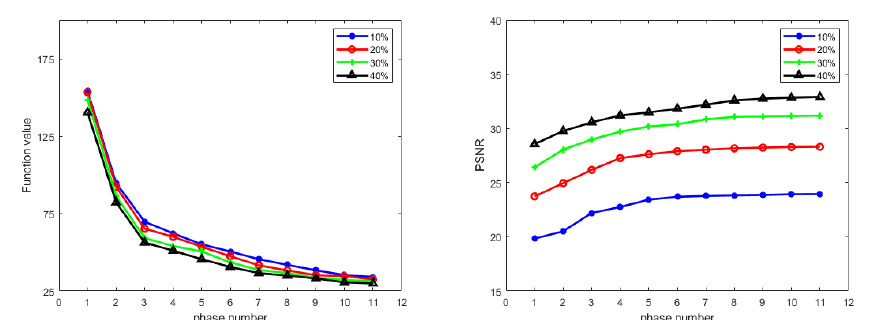
Figure 6. Convergence behavior of Algorithm 1 on T1 weighted MRI image reconstruction with four different CS ratios using radial mask. Left : Objective function value φ versus phase number. Right : PSNR value versus phase